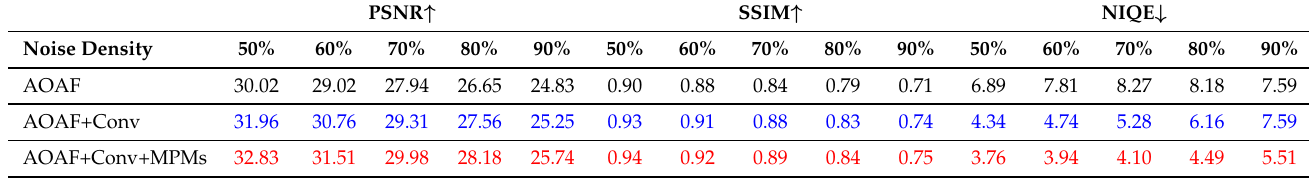
Table 2. Ablation study of the proposed framework. All the scores are averaged over the test dataset. The best score in each column is marked in red and the second-best in blue.